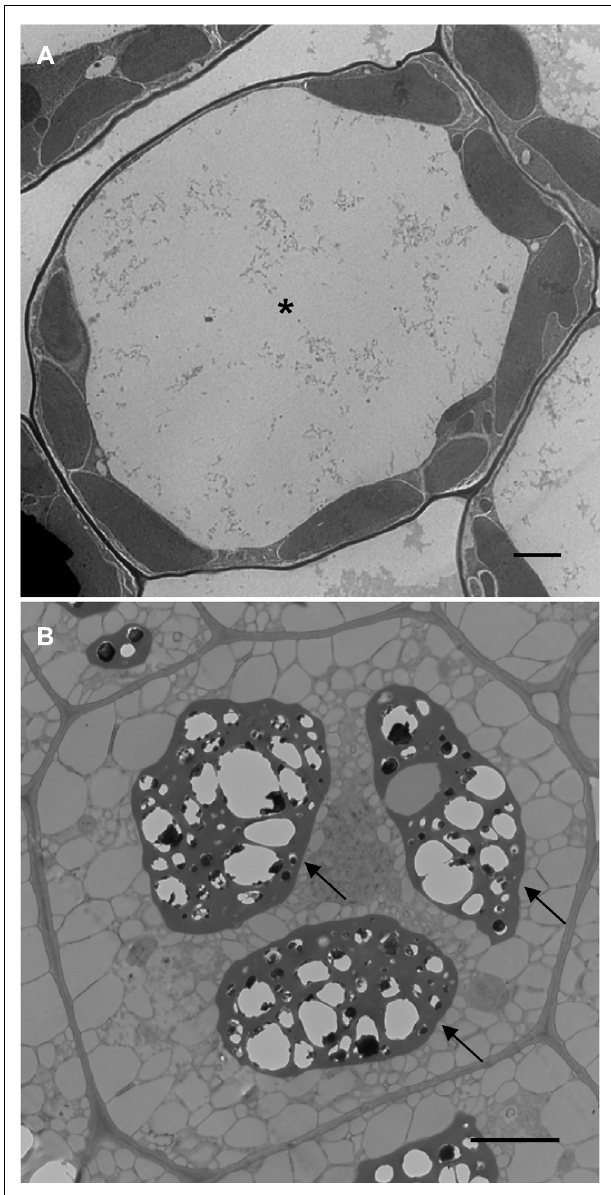
FIGURE 1 |Transmission electron microscope images of Arabidopsis leaf (A) and seed (B) cells. Asterisk shows the LV and arrows point to PSVs. Bars = 2 μ